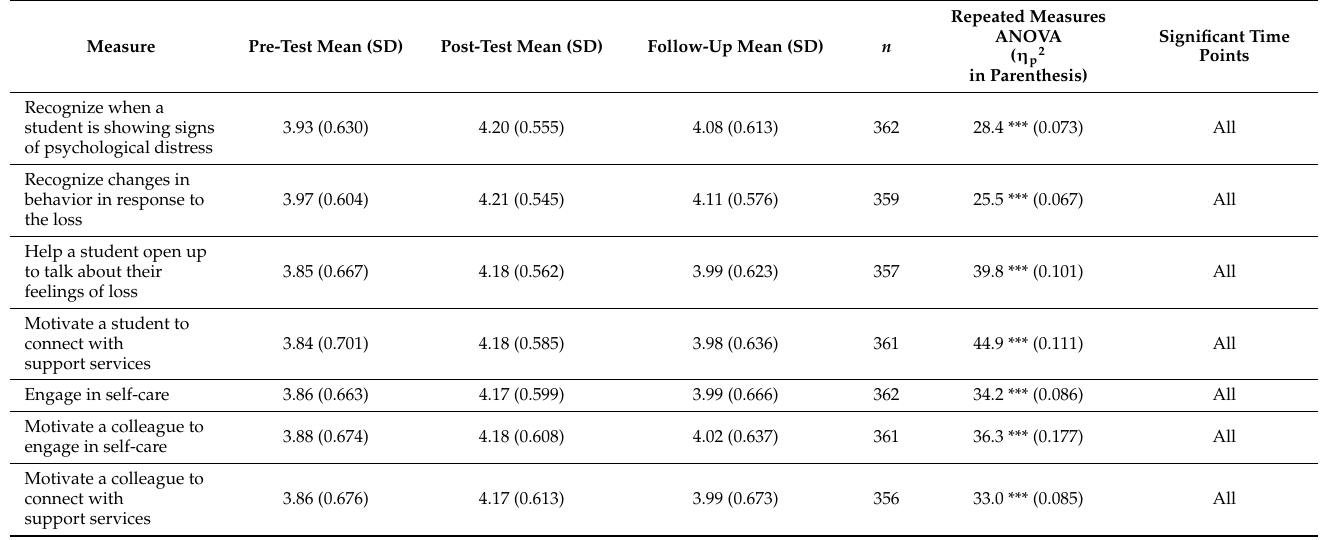
Table 3. In response to a real or possible death in your school or community, please indicate how much you disagree/agree with the following statements that begin with “I feel confident in my ability to”.